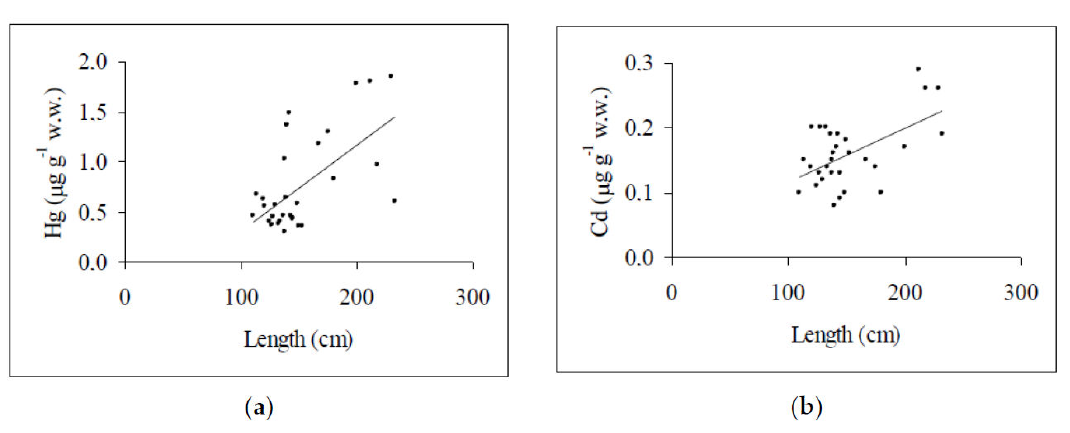
Figure 1. Correlation between Hg ( a ) and Cd ( b ) concentrations and